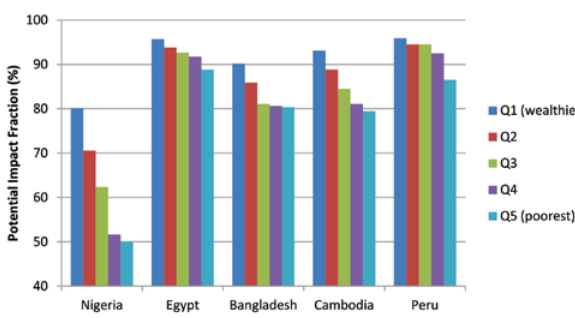
Figure 9 Effectiveness/Potential Impact Fraction (PIF) model for community case management (CCM) in each country by wealth quintile s in exemplar countries.